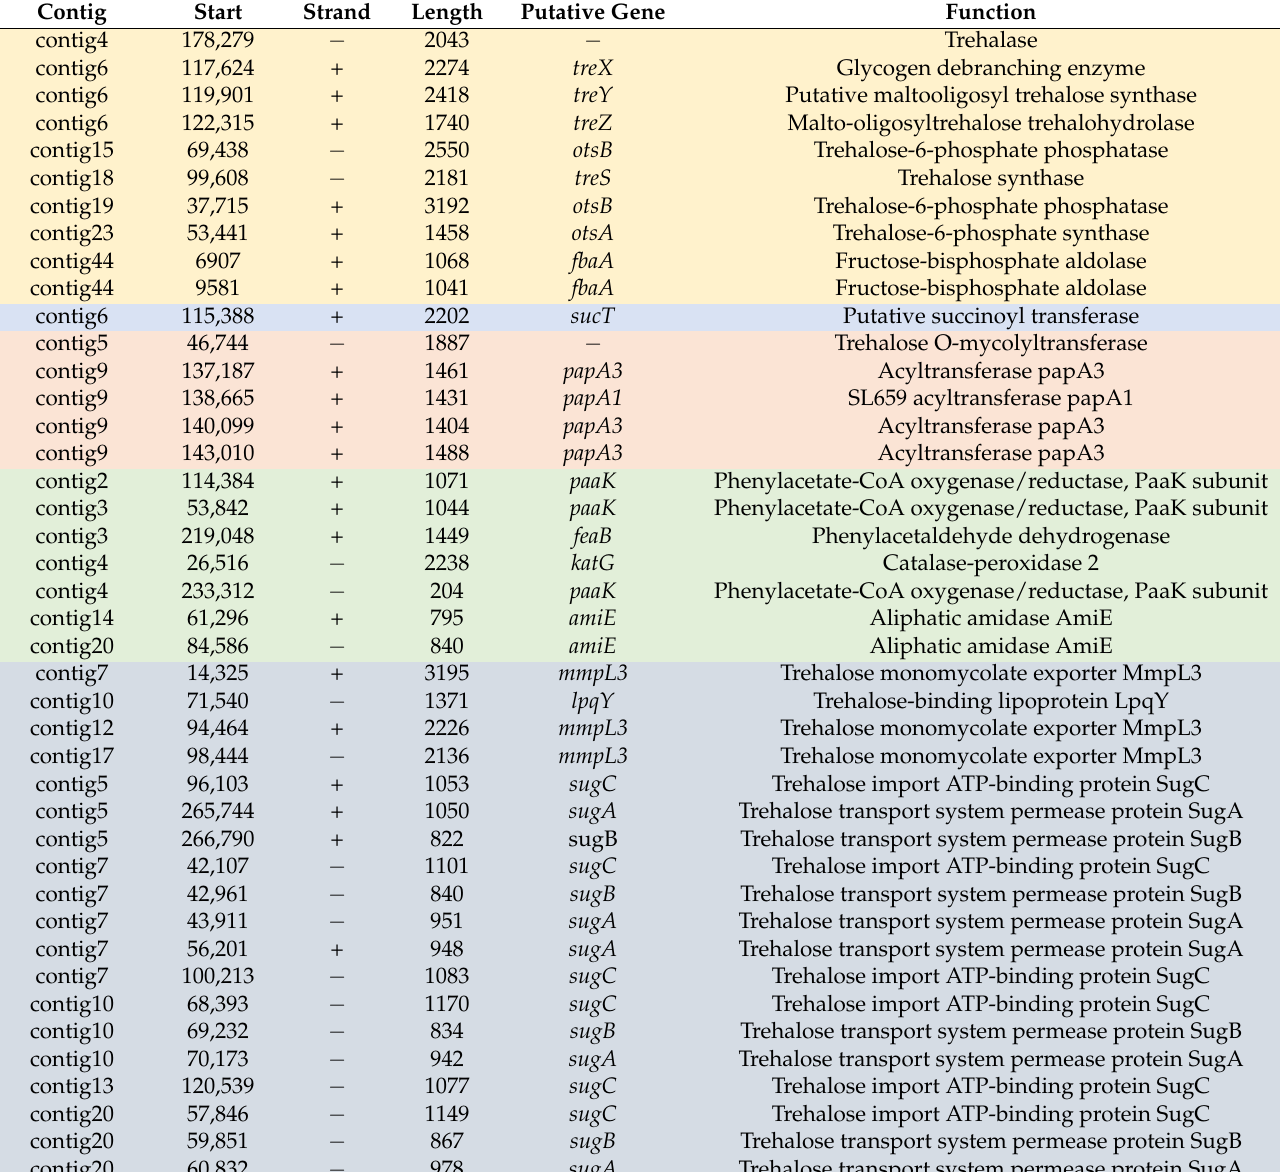
Table 5. Putative genes involved in the biosynthesis of the novel succinic saccharide